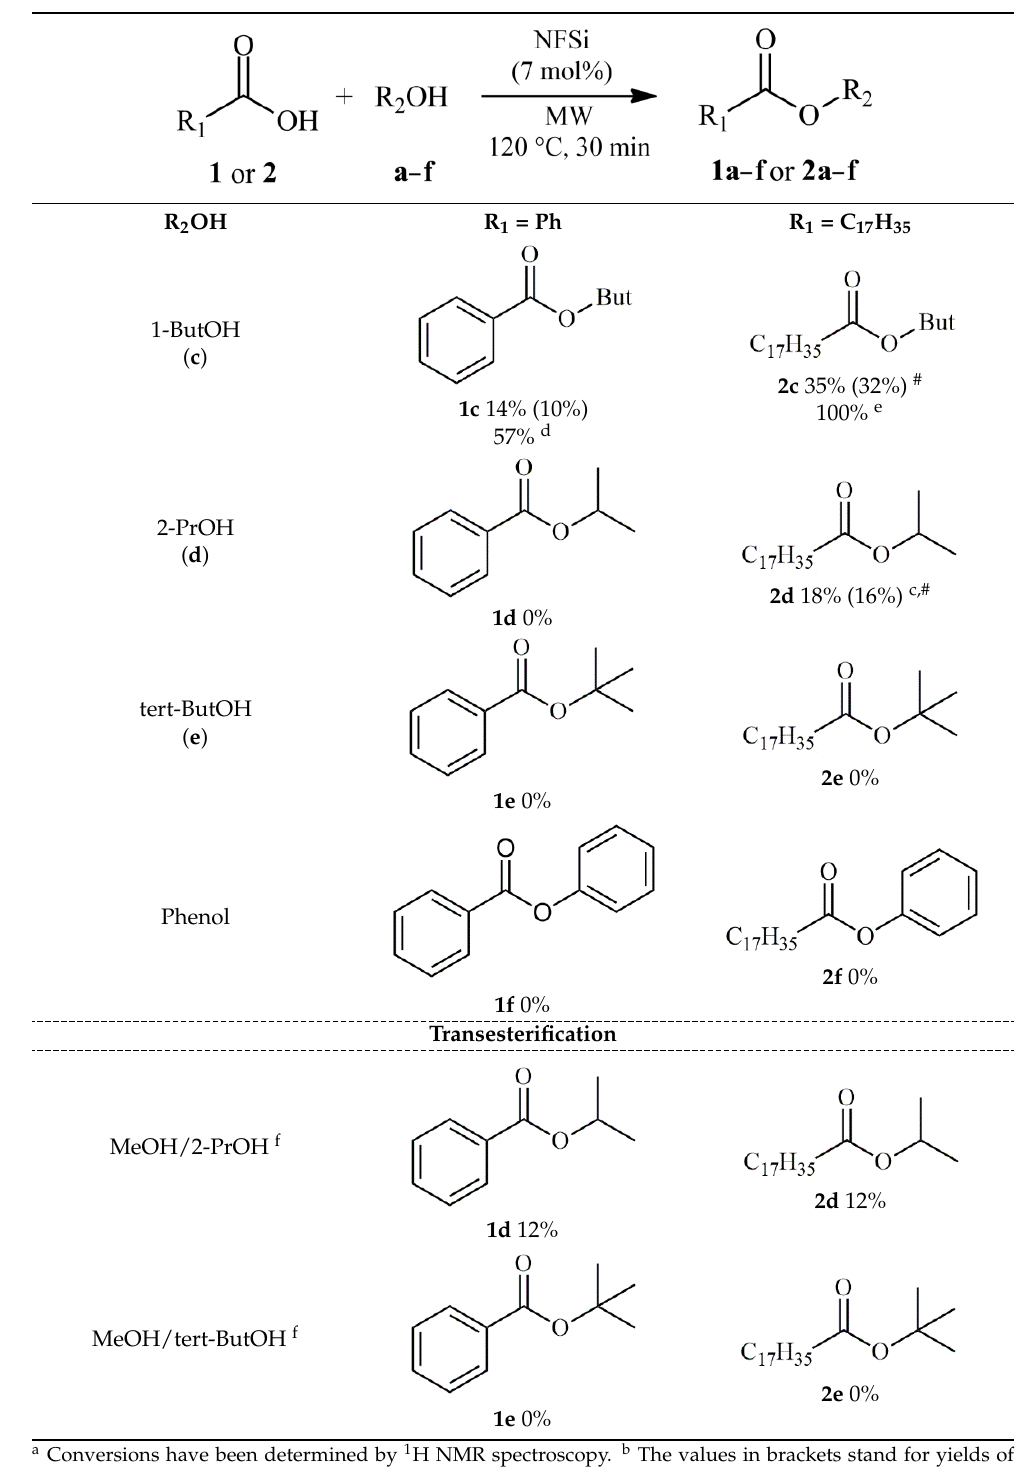
Table 2. Cont. Table 2. The effect of alcohol structure on esterification of benzoic ( 1 ) and stearic acid ( 2 ) a,b